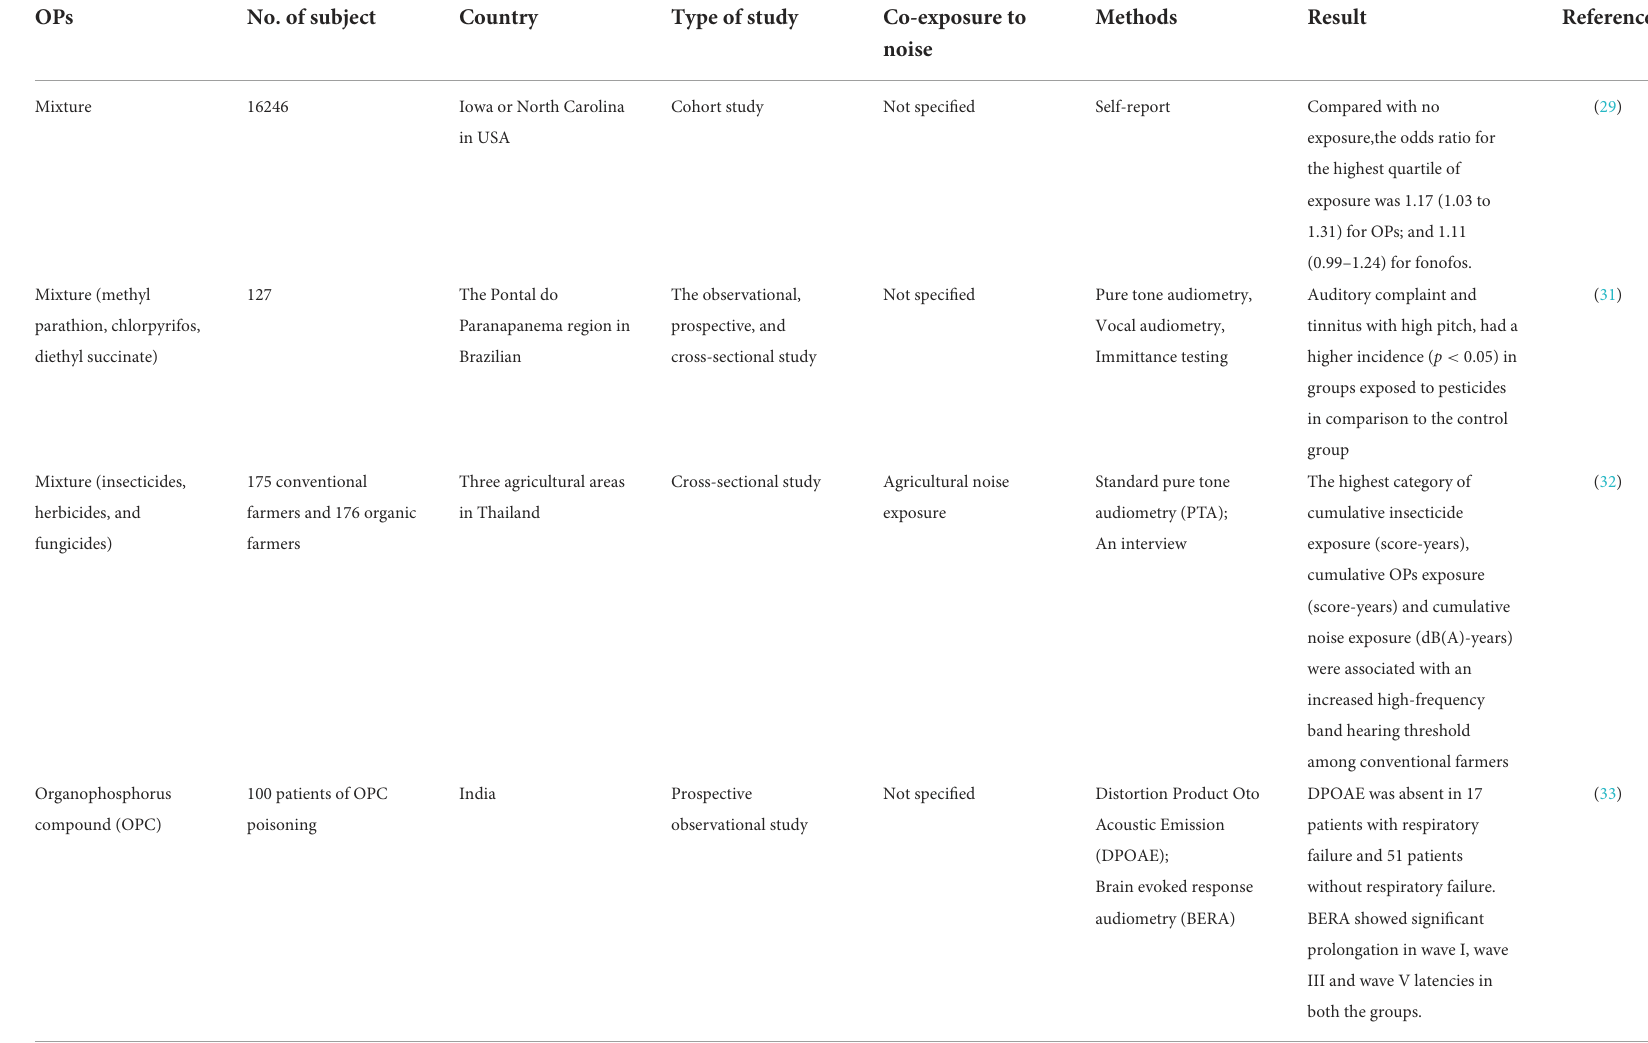
TABLE 1 Epidemiological studies on the effects of exposure to organophosphorus pesticides (OPs) on human auditory